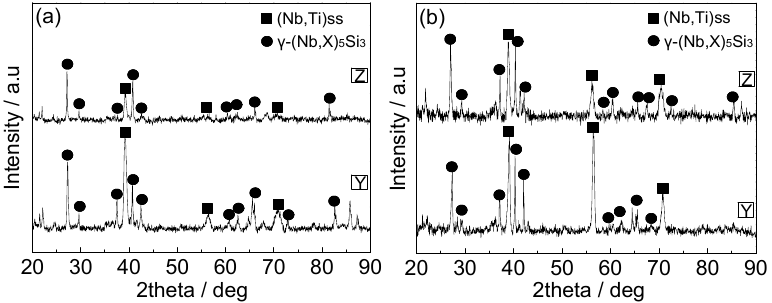
Figure 8. XRD patterns of the alloy re-melted in Z and Y mold shells in a vacuum furnace with ( a ) a tungsten and ( b ) a graphite heating element.